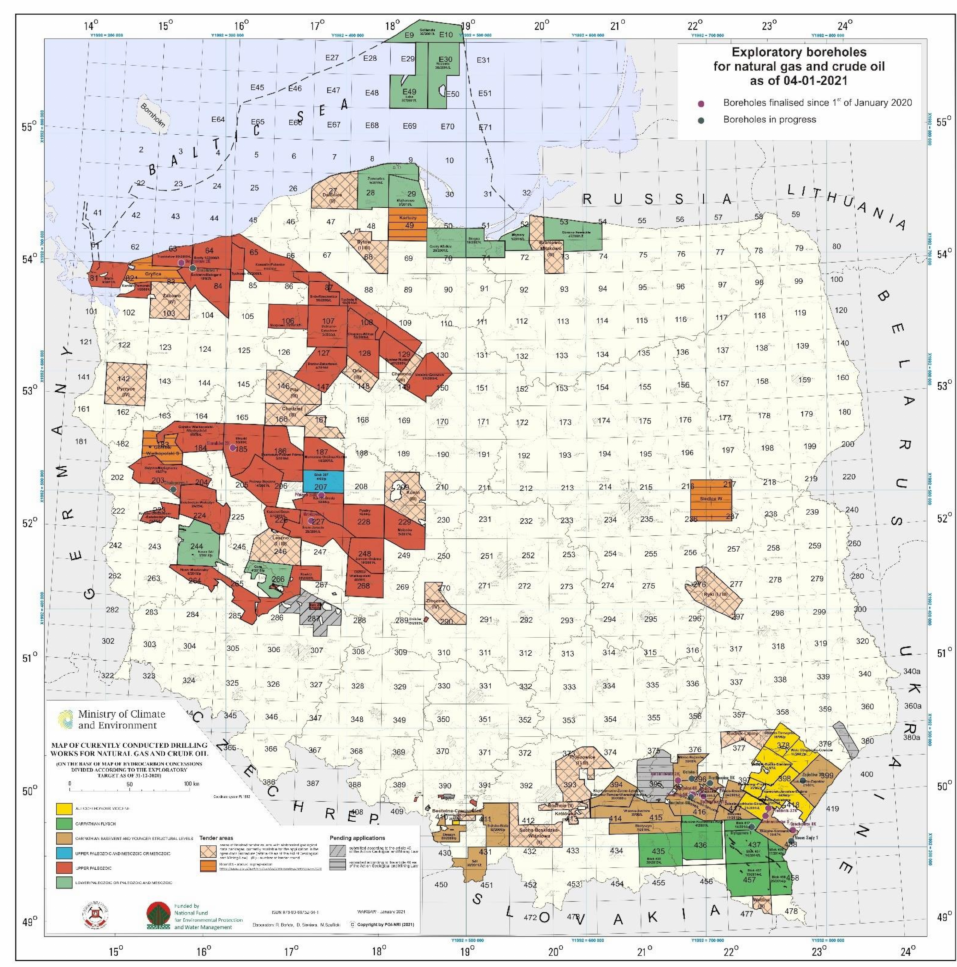
Figure 1. Occurrence of natural gas deposits, as of 31 December 2020